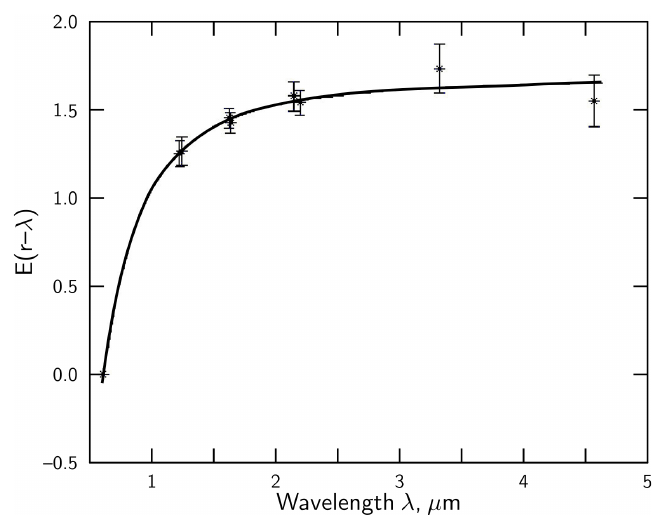
Fig. 3. Wavelength dependence of the color excess E ( r − λ ) for NGC 1857. The asterisks and solid line show the inferred values and the corresponding E r − λ = a + bλ − α fit, respectively.